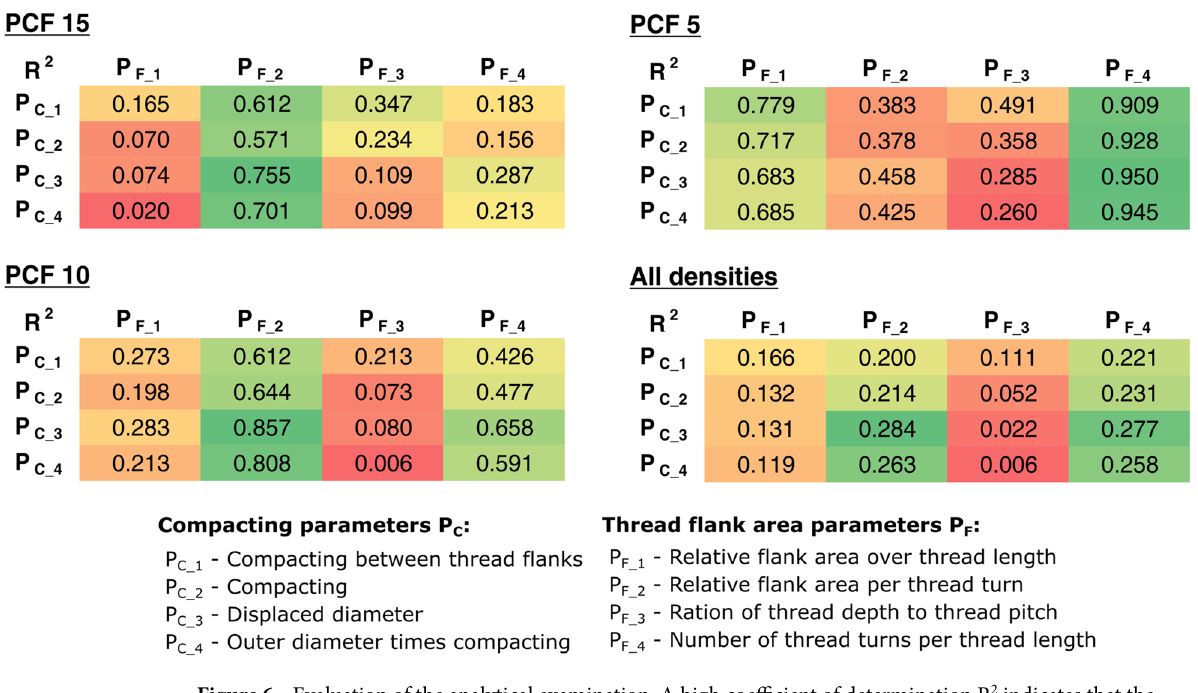
Figure 6. Evaluation of the analytical examination. A high coefficient of determination R 2 indicates that the considered parameters (P C and P F ) represent the correction factor well. The most favourable combinations are highlighted in green. The comparisons were made for the individual material densities (PCF 15, PCF 10 and PCF 5) and across all material densities of the synthetic foam.